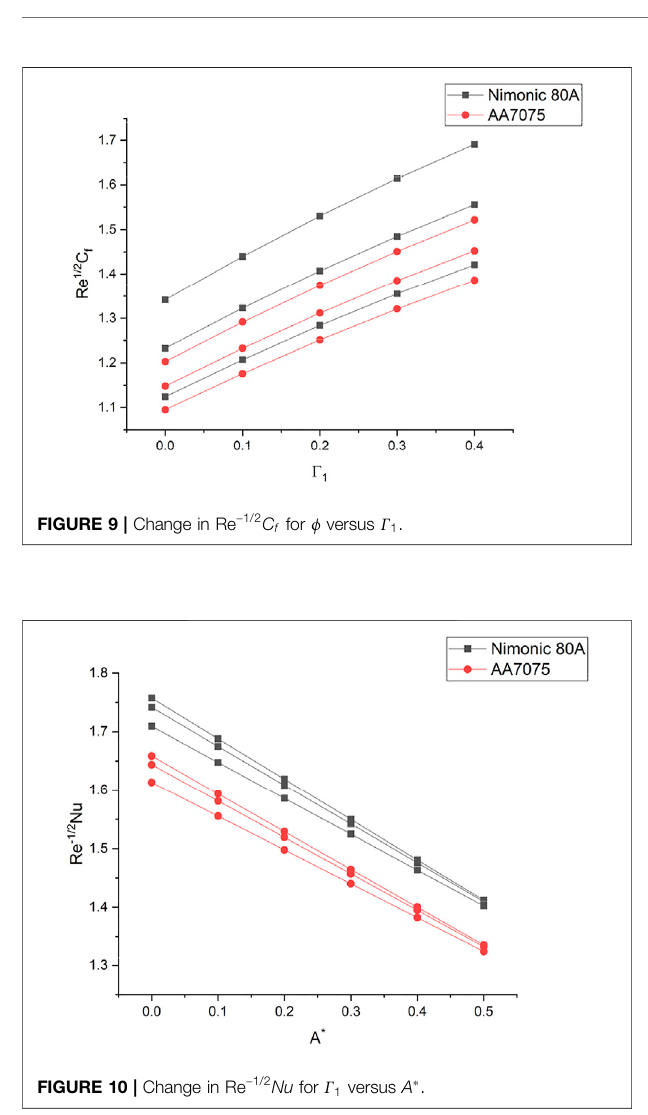
FIGURE 12 | Change in Re − 1/2 Sh for Sc versus σ